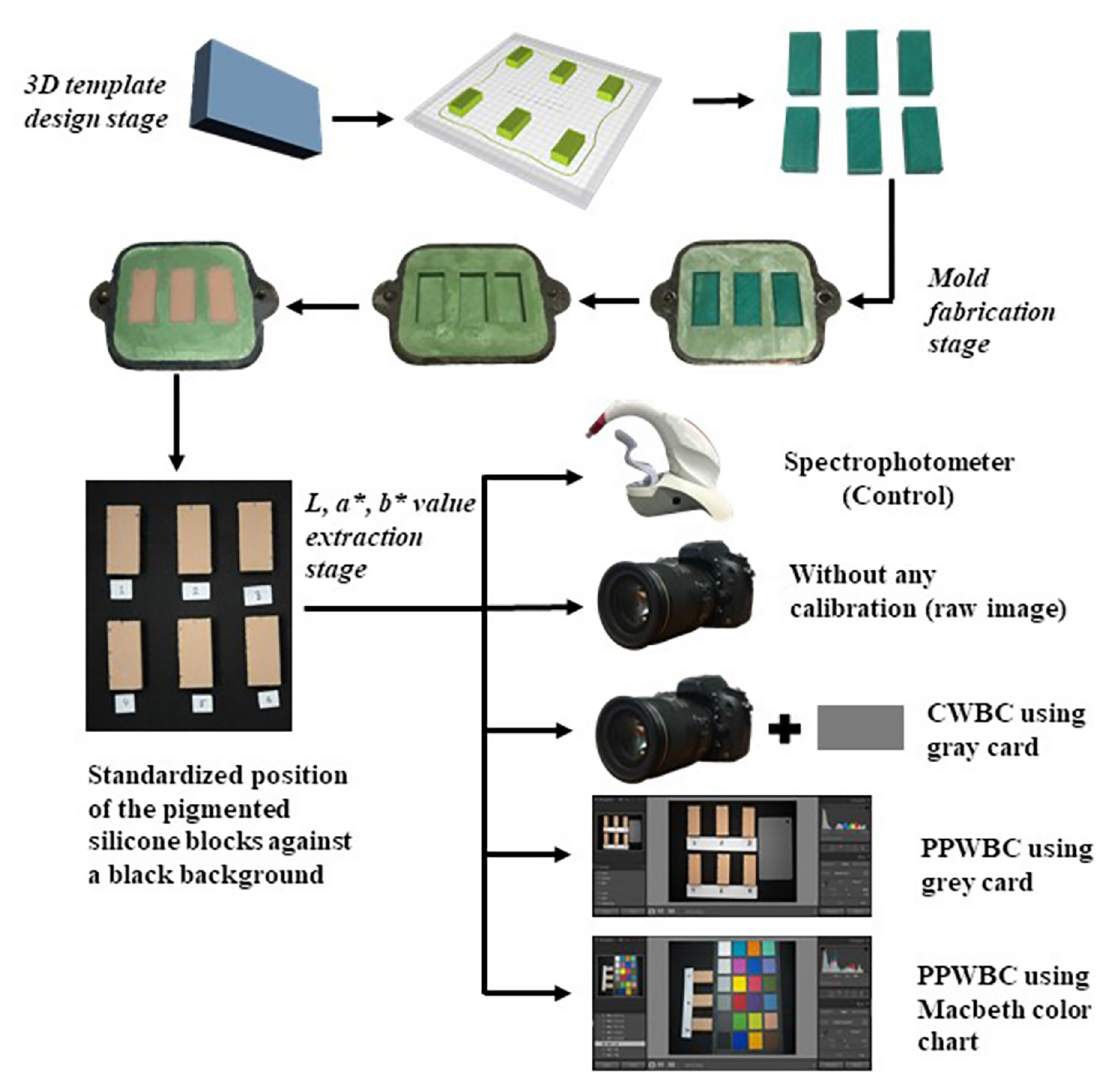
Fig 2. Workflow summary of the current